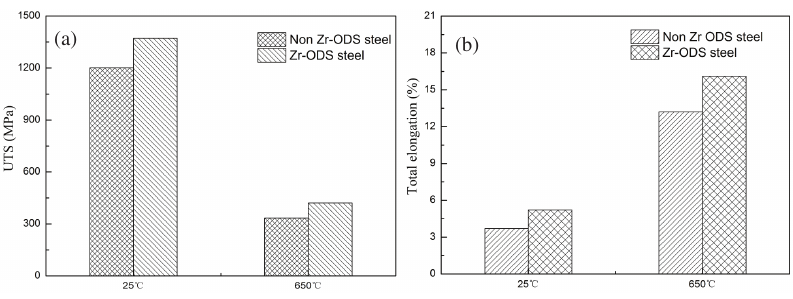
Figure 8: Tensile properties of 14Cr-ODS steels at RT and 650°C (a) UTS, (b)